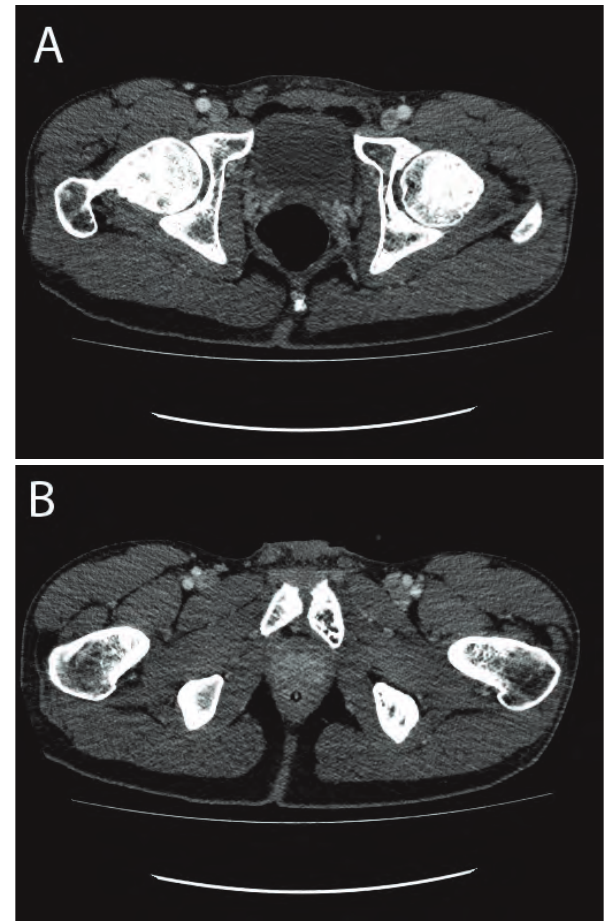
Fig. 7. (a) Pre- and (b) post-chemotherapy. Sequential axial post-contrast CT slices through the pelvis confirm complete resolution of the soft-tissue component. Note the residual permeated changes involving the pelvic